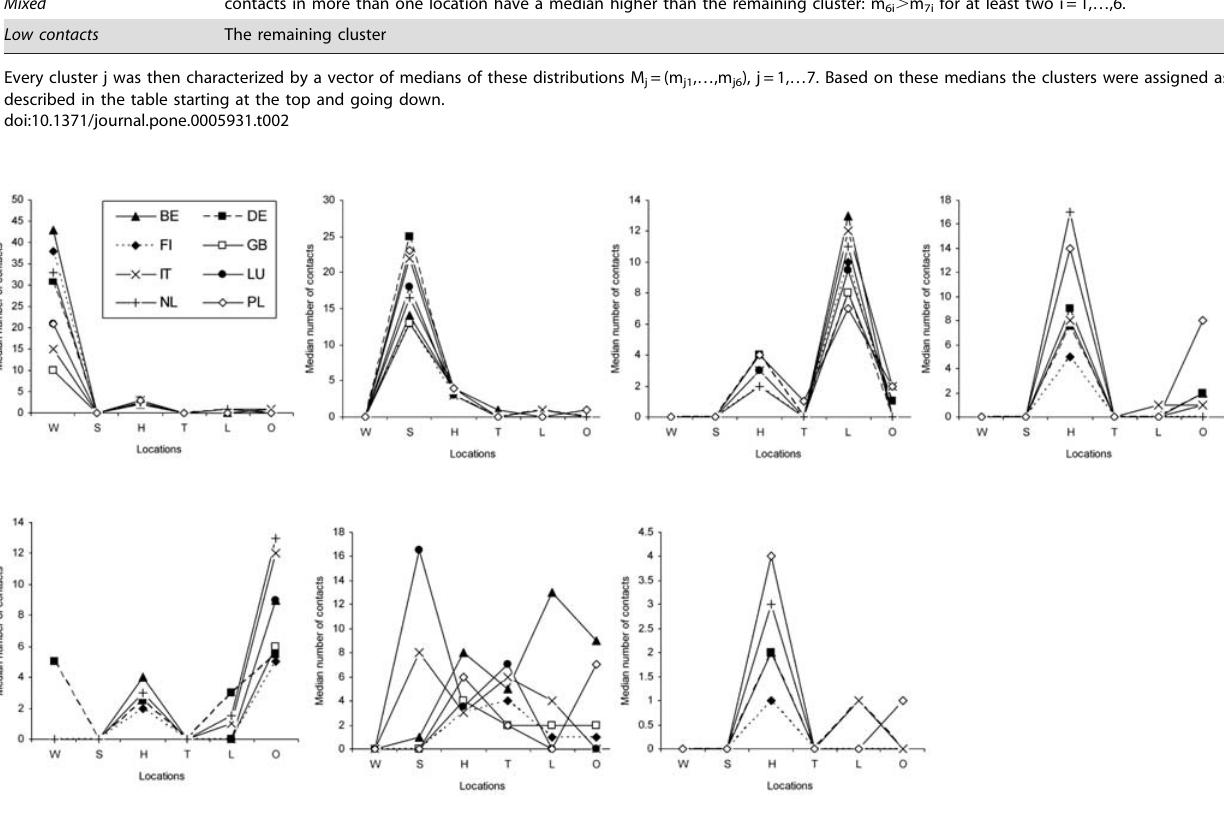
Figure 1. Distribution of contacts across locations for each contact profile by country (W=work, S=school, H=home, T=transport, L=leisure, O=other place).